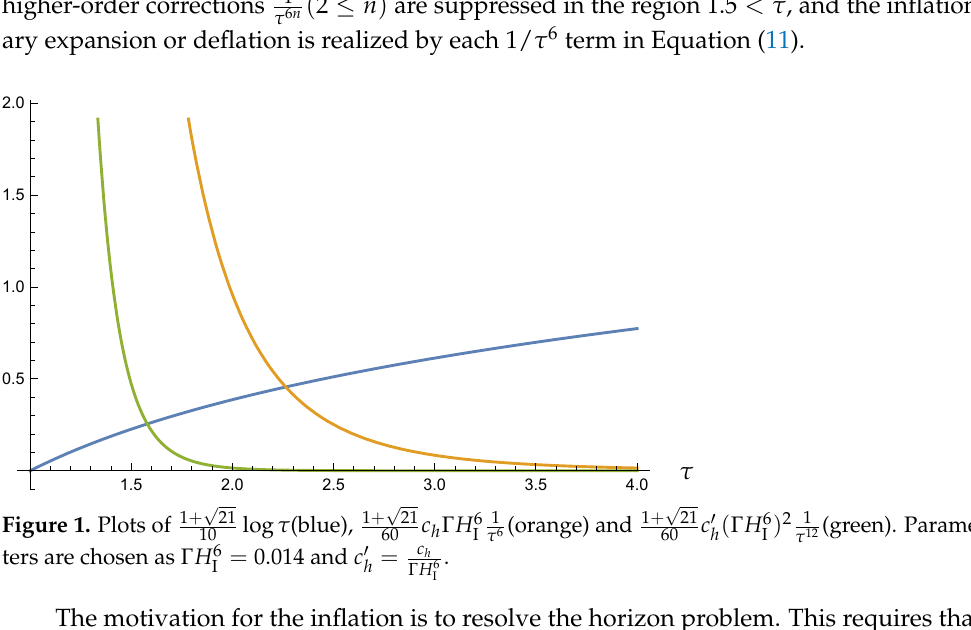
√ 21 ( Γ H 6 ) 2 1 c (cid:48) (green). Parame- 60 h I τ 12